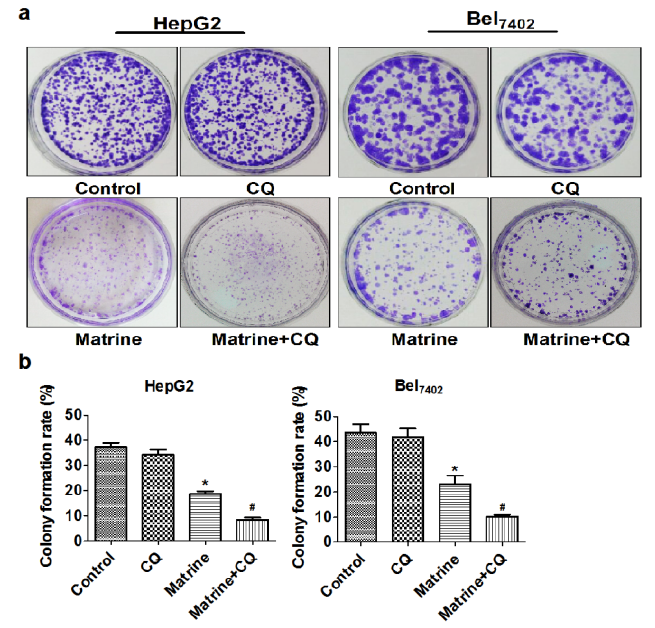
Figure 2. The suppressive effect of matrine with or without CQ on colony formation of hepG2 and Bel cells. ( a ) Representative images of colony-forming assay; ( b ) Analysis 7402 of Colony formation rates of hepG2 and Bel cells. Data are means ± SD of 7402